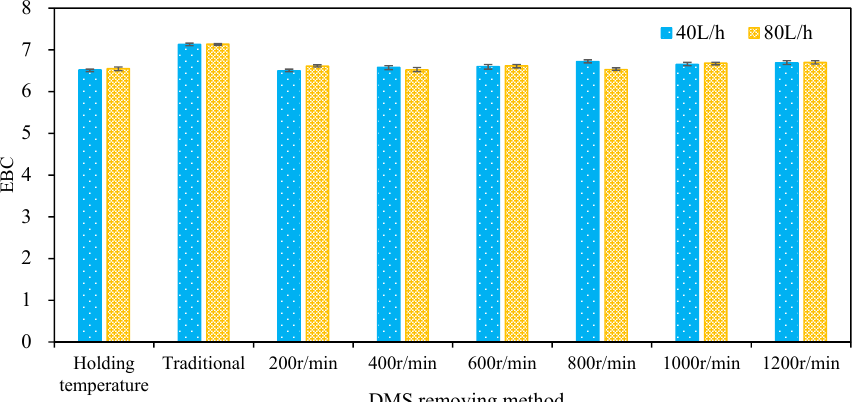
Figure 10. Effect of the DMS removal method on wort color.